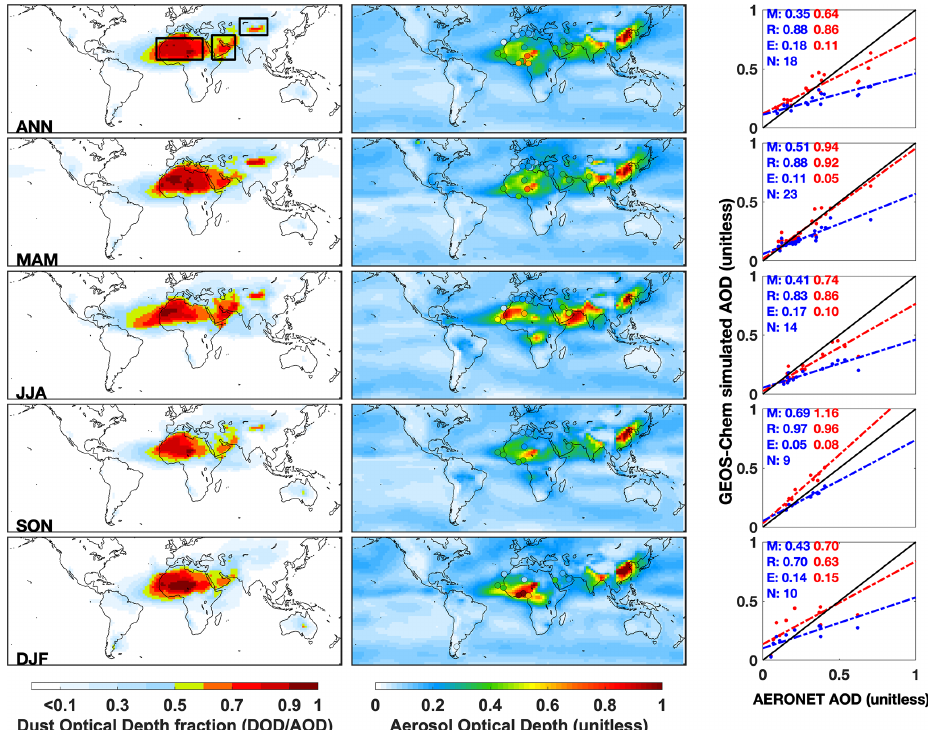
Figure 3. Annual and seasonal mean simulated dust optical depth (DOD) fraction (left column) and aerosol optical depth (AOD) (middle column) from GEOS-Chem simulations for 2016, and AERONET measured AOD at sites where the ratio of simulated DOD and AOD exceeds 0.5, which are shown as filled circles in the middle column. Boxes in the left top panel outline the three major deserts examined in Fig. 4. The right column shows the corresponding scatter plot with root mean square error ( E ), correlation coefficient ( R ) and slope ( M ) calculated with reduced major axis linear regression. N is the number of valid ground-based monitoring records. The results for the simulation using the original dust emissions are shown in blue; the results for the simulation using updated dust emissions with dust strength of 2000Tgyr − 1 are shown in red. The best-fit lines are dashed. The 1:1 line is